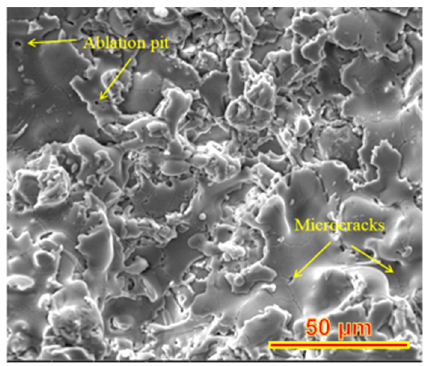
Figure 3. Microstructure of Y 2 O 3 coating after laser micromelting.